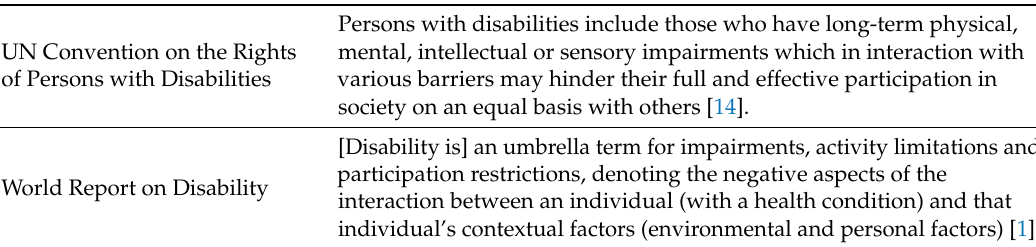
Table 1. Definitions of